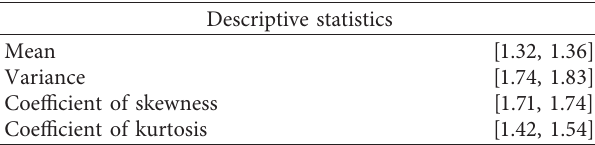
Table 3: Descriptive summary of the air conditioning system data using the NGD